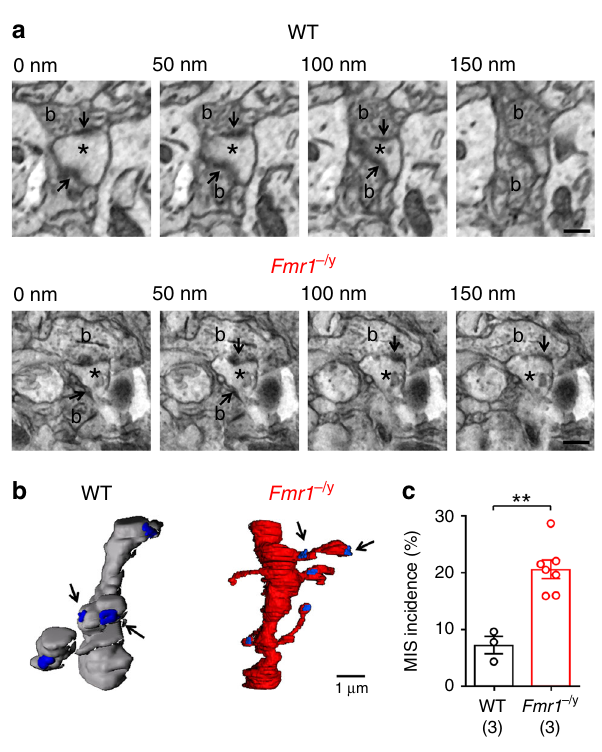
Fig. 4 L4 spines in Fmr1 − /y mice form multiple synaptic contacts. a Serial electron micrographs in L4 from WT and Fmr1 − /y mice, indicating spines (asterisk) contacted by multiple presynaptic boutons (b) each with a PSD (arrows); scale bar: 500 nm. b Reconstructed dendrites from WT (grey) and Fmr1 − /y (red) mice, with PSDs (blue) and MIS indicated (arrows). c Incidence of MIS in WT and Fmr1 − /y mice. Statistics shown: ** p < 0.01 from unpaired t -test. All data are shown as mean ± SEM and source data for all plots are provided as a Source Data fi